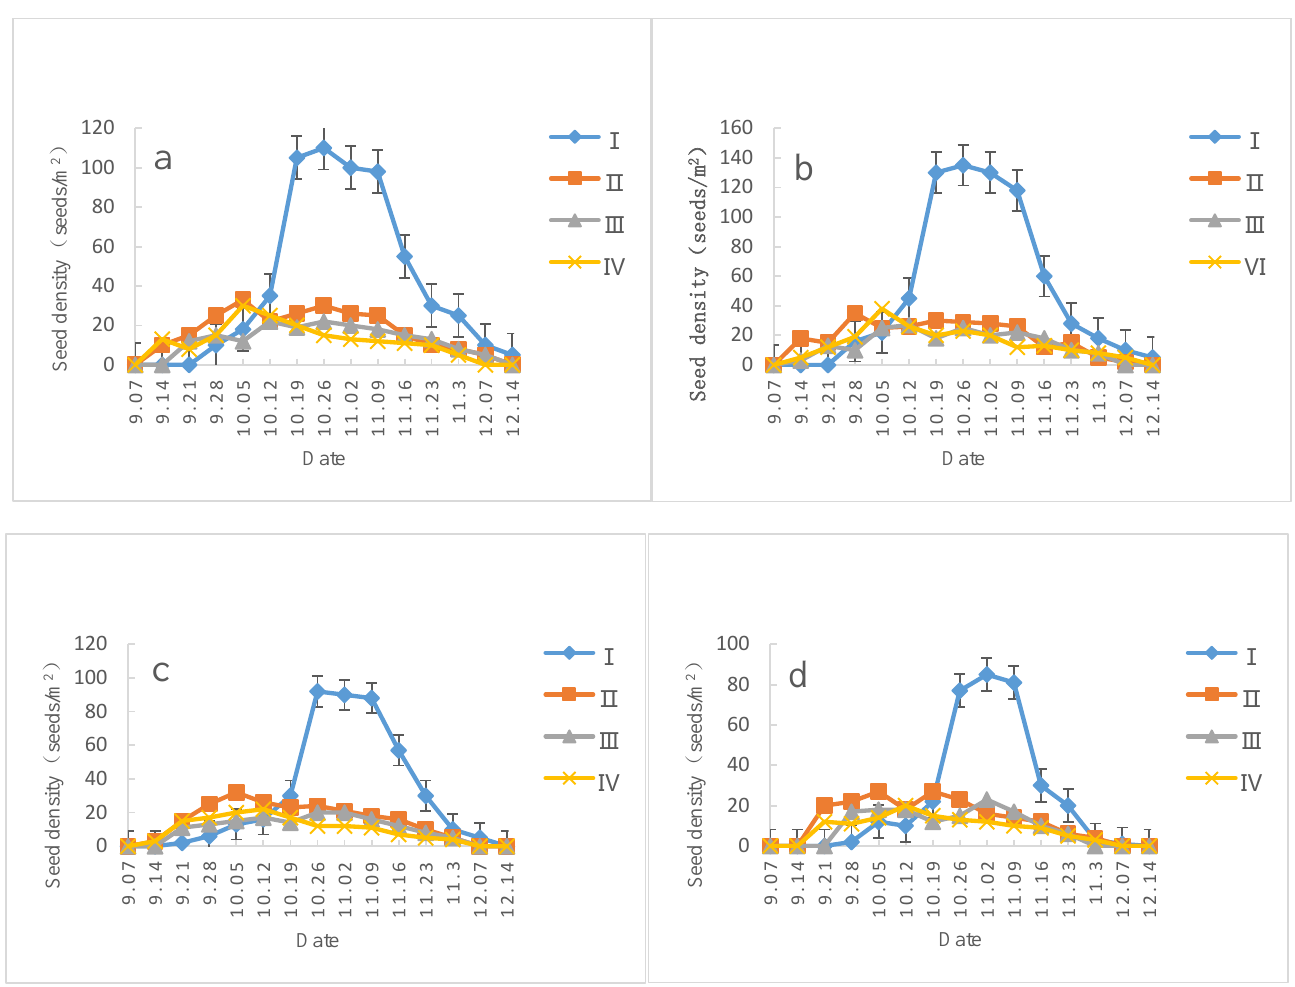
Figure 2. ( a ) semi-sunny slope; ( b ) sunny slope; ( c ) semi-shady slope; ( d ) shady slope. Temporal dynamics of Castanopsis hystrix seed rain on different slope directions in 2017. (I) Mature seed (blue); (II) immature seed (orange); (III) seed damaged by insects (gray); (IV) nibbled seed (yellow).